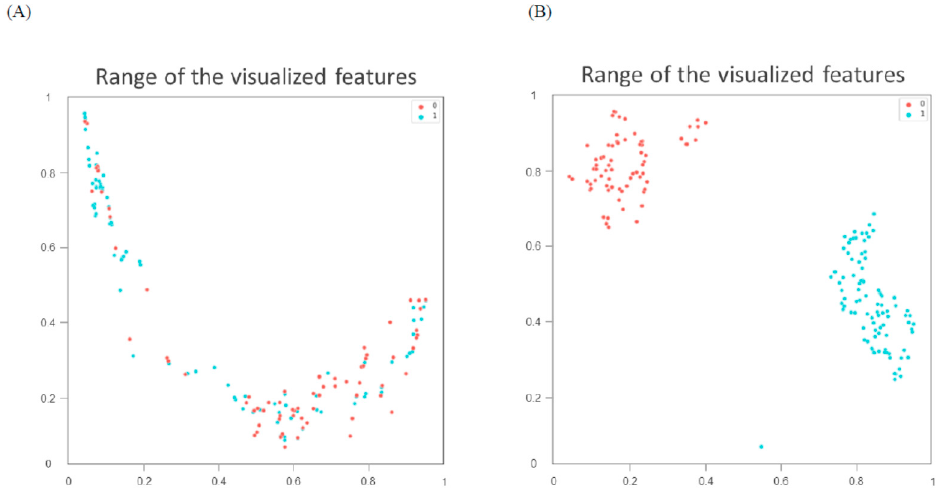
Figure 3. Distribution of visualized features for training model before ( A ) and after ( B ) metric learning and dimensionality reduction using Uniform Manifold Approximation and Projection. Blue spots represent tumor regression grade 3 or 4 responses; red spots correspond to responses lower than grade.